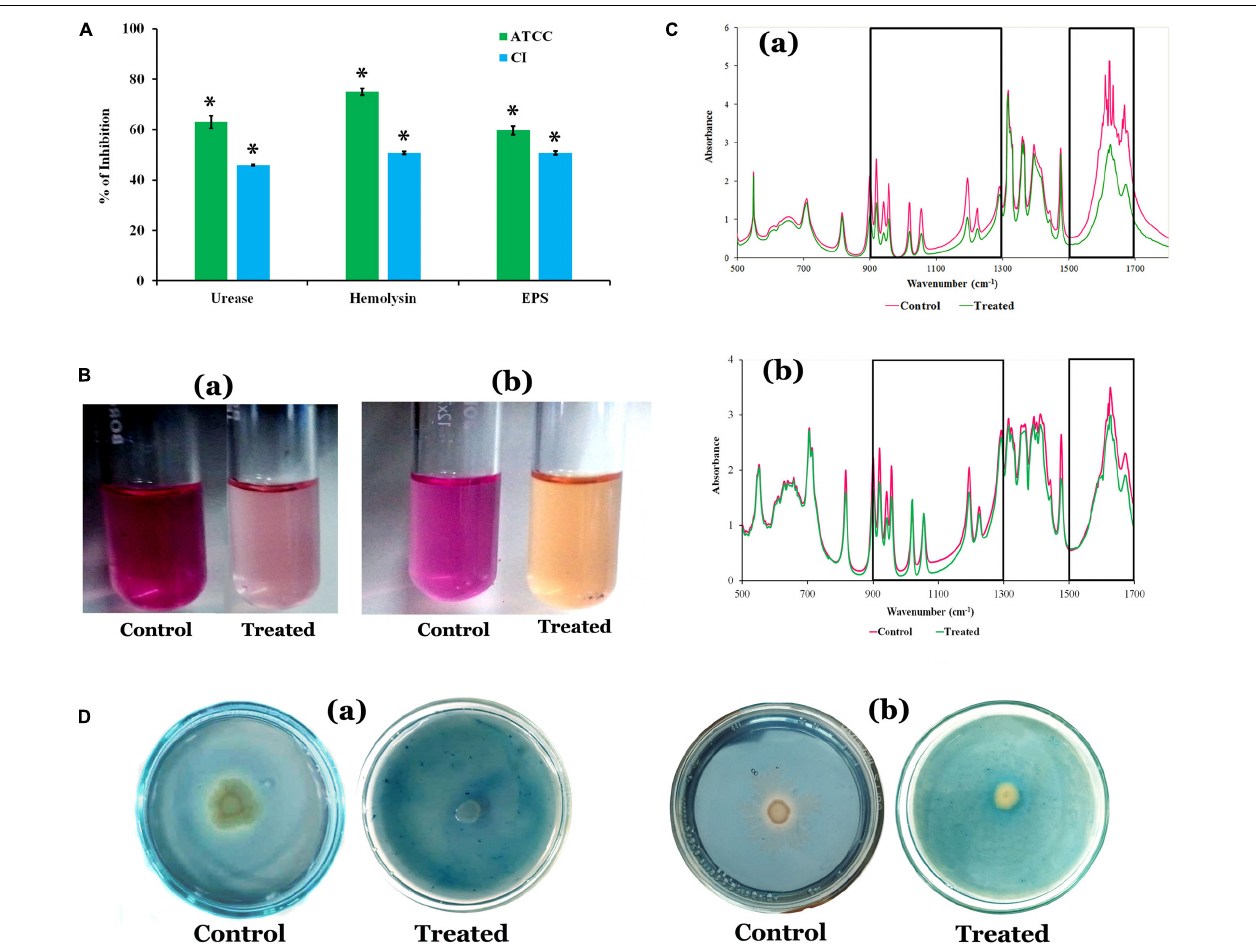
FIGURE 2 | (A) Effect of HMB (at its MBIC) on Proteus mirabilis virulence factors such as urease, hemolysin, and EPS production. Data represent mean values ( n = 3) ± standard deviation. ∗ indicates significance at P < 0.005. (B) Representative images of test tubes displaying urease inhibitory potential of HMB (MBIC) on P. mirabilis (a) ATCC and (b) CI. (C) FT-IR analysis of the EPS samples extracted from the HMB-treated (at its MBIC) and untreated P. mirabilis (a) ATCC and (b) CI. Box I represents the region of polysaccharides and nucleic acids (1,300–900 cm − 1 ), and box II represents the region of proteins (1,500–1,700 cm − 1 ). (D) Siderophore inhibitory potential of HMB at its MBIC on P. mirabilis (a) ATCC and (b) CI. HMB, 2-hydroxy-4-methoxybenzaldehyde; MBIC, minimum biofilm inhibitory concentration; EPS, exopolysaccharide; ATCC, American Type Culture Collection; CI, clinical isolate; FT-IR, Fourier transform